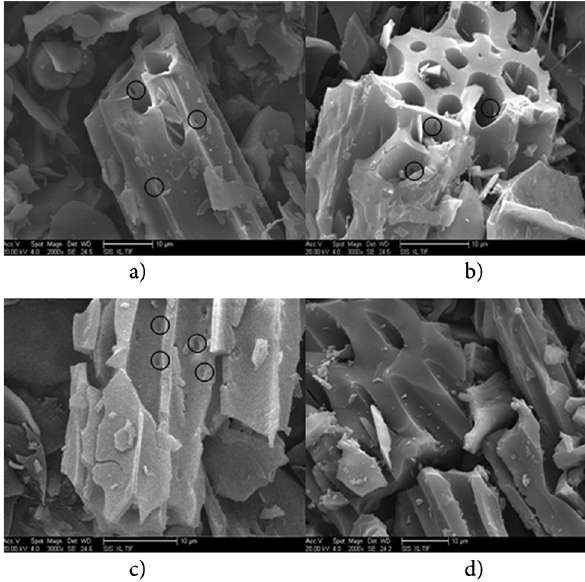
Figure 7. SEM pictures of different stalk carbon samples (a: ACsR2T350t70; b: ACcR2T350t70; c: ACmR2T350t70; d: ACmR0T350t70)